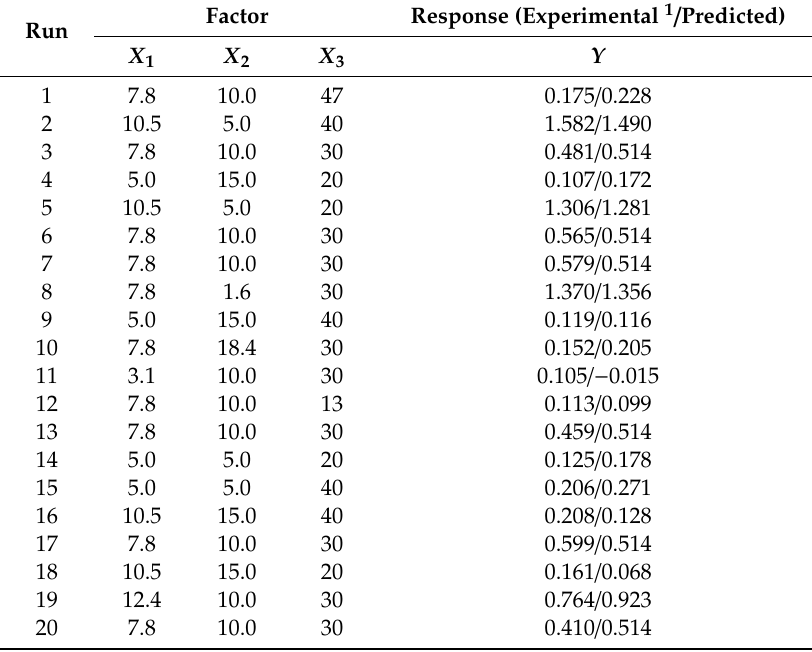
Table 1. Experimental design for three-factor five-level central composite design as well as comparison between experimental and predicted response values for the growth of the indigenous isolate Enterococcus casseliflavus ( Y , optical density at 630 nm) in MRS broth. Factor Response (Experimental 1 / Predicted) Run X